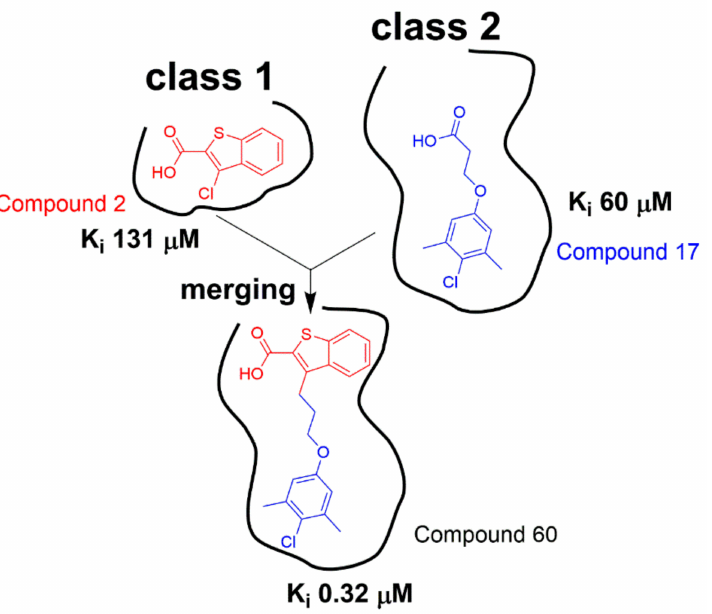
Figure 5. Class 1 hits and class 2 hits were identified to bind to two different but adjacent pockets in Mcl1. Then, linking and merging strategies were jointly applied to the structure optimization of hit compounds (adapted from reference